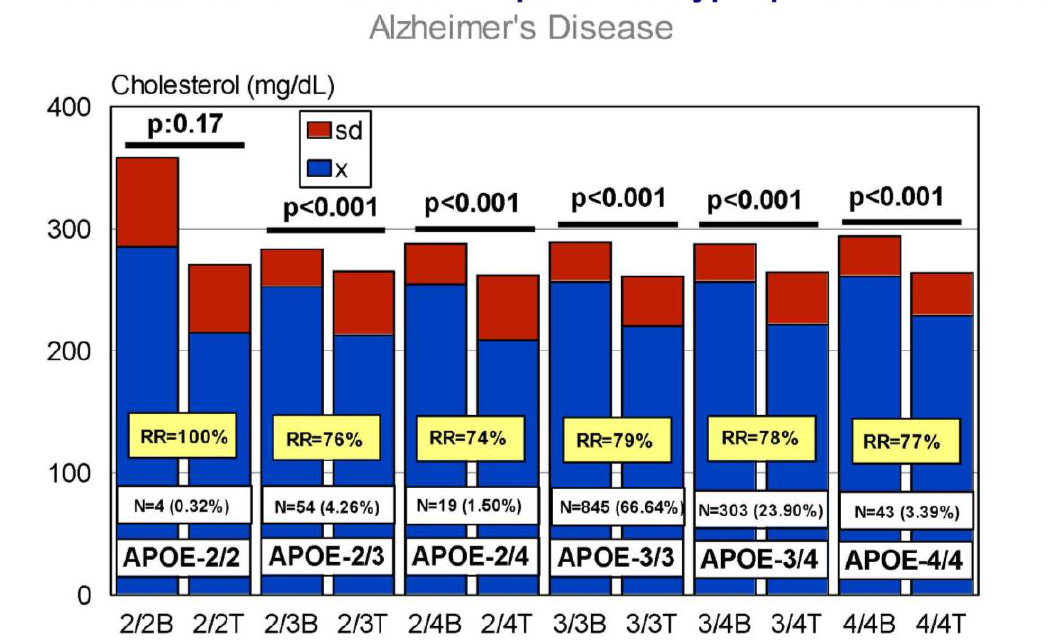
Figure 7. APOE -related cholesterol response to a hypolipemic treatment in hypercholesterolemic patients with Alzheimer’s disease. B: Basal values; T: Treatment (Atorvastatin: 10–20 mg/day; LipoEsar: 500 mg/day).